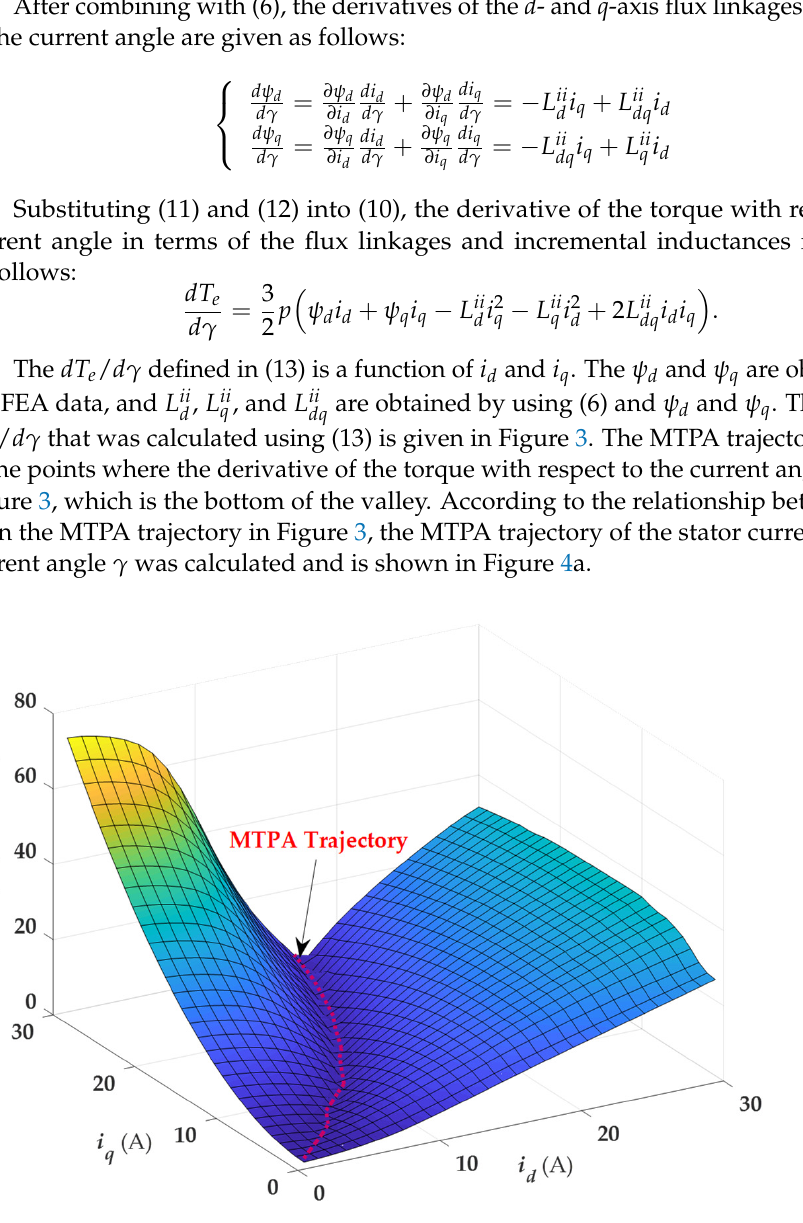
Figure 3. The derivative of torque with respect to the current angle and the maximum torque per ampere (MTPA) trajectory.